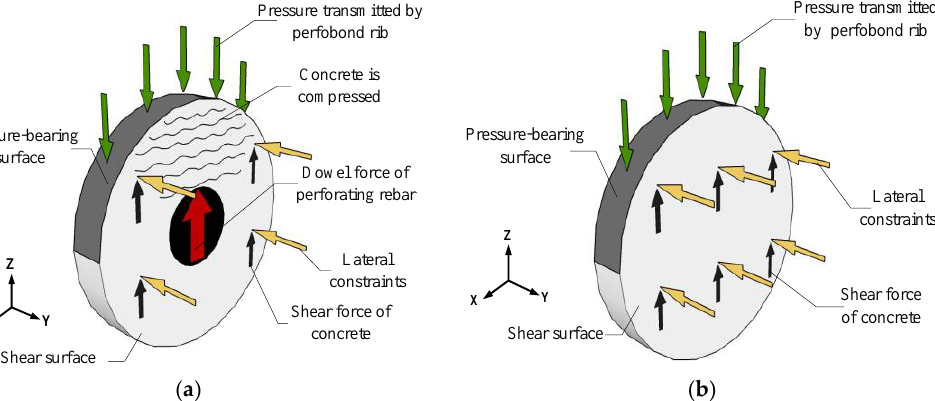
Figure 12. Shear-failure mechanism of the perfobond connector : ( a ) Shear-failure mechanism of perfobond connector with perforating rebar; ( b ) Shear-failure mechanism of perfobond connector without perforating rebar.